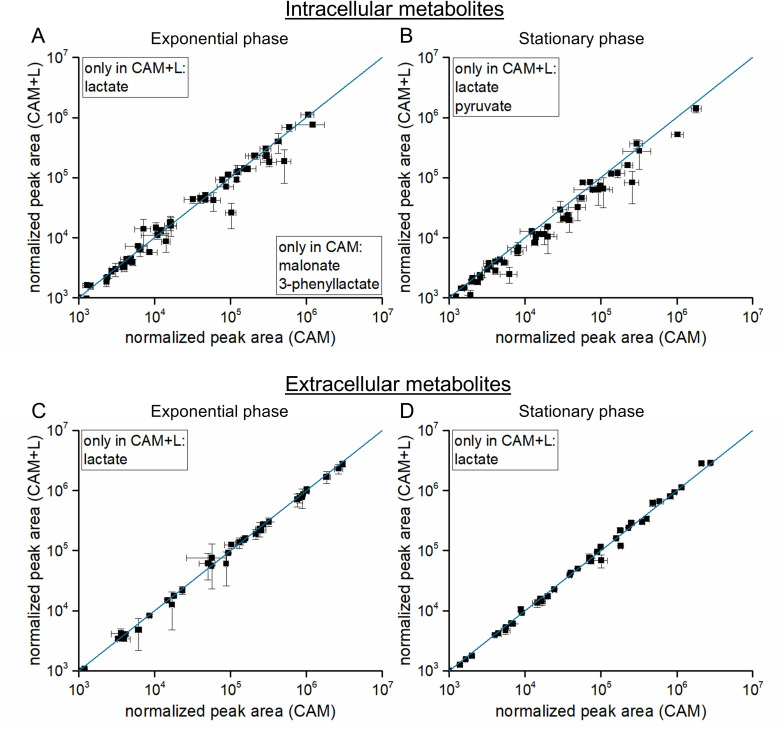
Scatterplots of the intracellular and extracellular metabolome analysis of C. difficile grown in absence and presence of L-lactate.Shown are the detected intracellular metabolites of the exponential (A) and the stationary phase (B) samples as well as the detected extracellular metabolites of the exponential (C) and the stationary phase (D) samples of C. difficile 630Δerm cultivated in casamino acids medium without (CAM) or supplemented with 500 mg/L L-lactate (CAM+L). The majority of metabolite concentrations remained unchanged (p-value < 0.05) for the two tested conditions. Metabolites detected only in one condition were shown in boxes. All experiments are based on four independent cultivations.